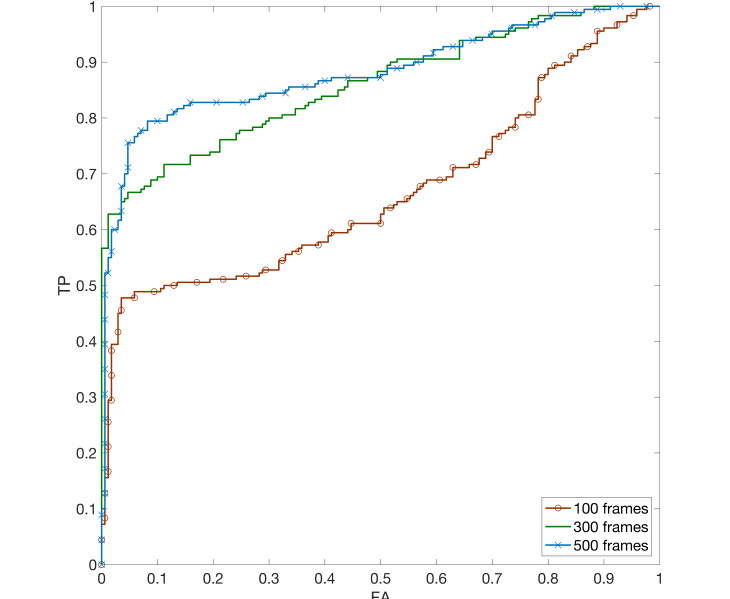
Figure 7. (Best viewed in color) Receiver Operating Characteristic (ROC) curve for profile linking between non-stabilized YouTube videos and Facebook high quality (HQ) images by varying the number of frames to estimate the video